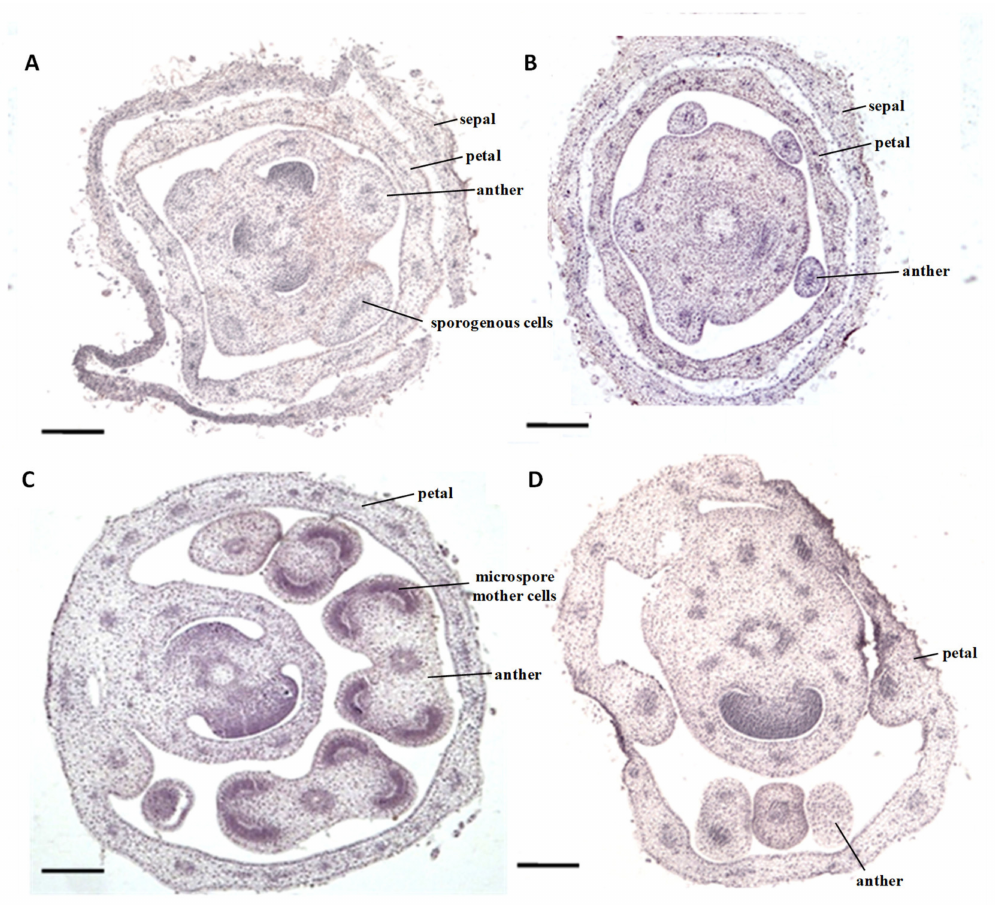
Figure 1. Microstructure of sua -CMS line msZY and its male fertile control ZY. ( A , B ) flower buds < 2 mm: ( A ) ZY, ( B ) msZY. ( C , D ) flower buds of 2mm-3mm: ( C ) ZY, ( D ) msZY. Scale bar = 200 µ